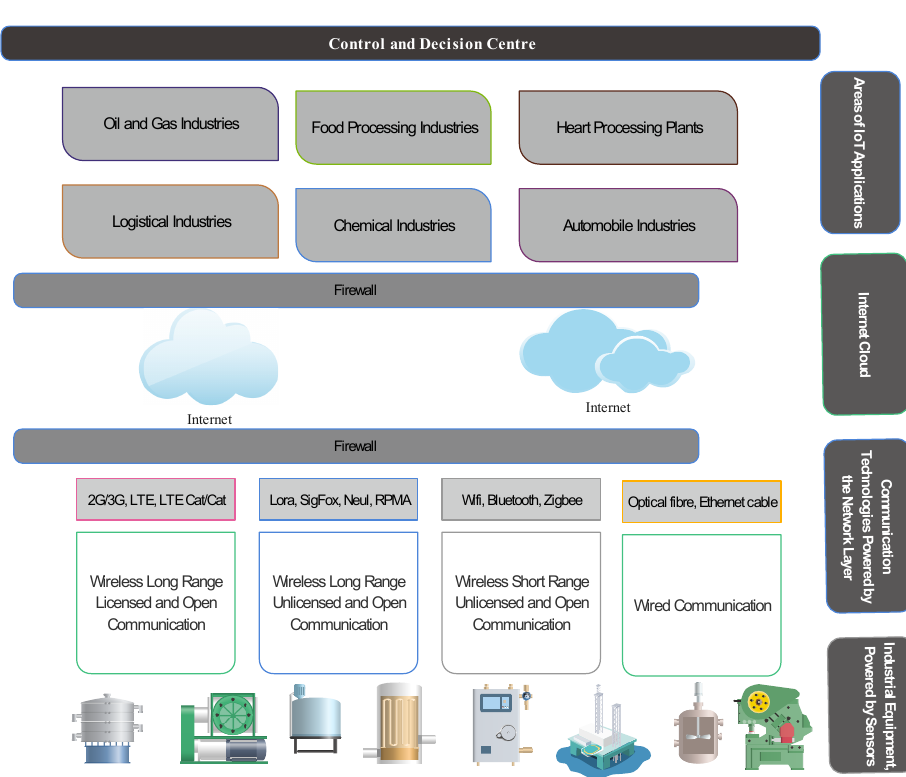
Figure 7. A typical structure of Industrial IoT (IIoT) showing basic